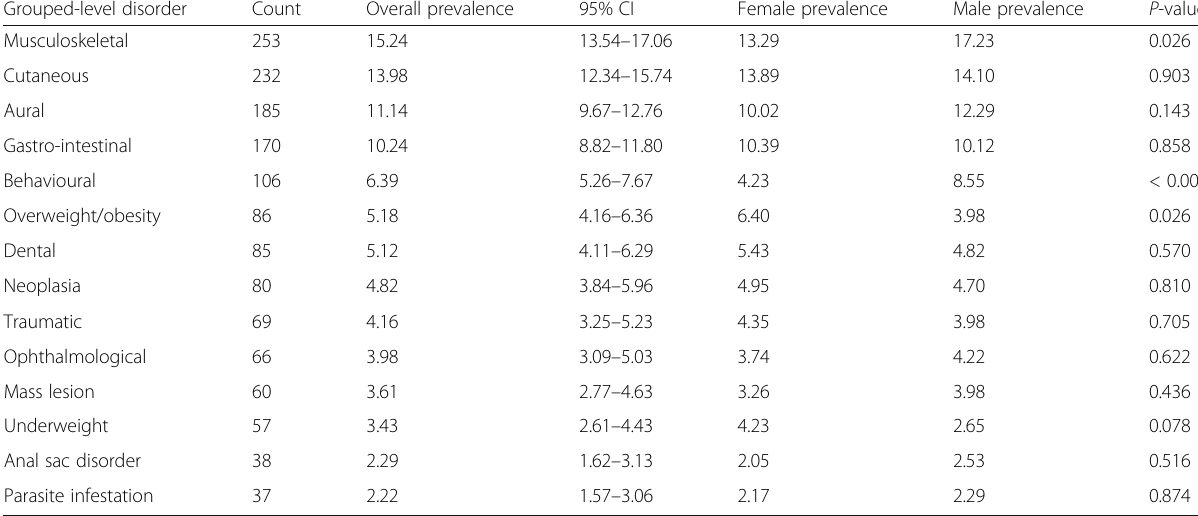
Table 4 Prevalence of the most common disorder groups recorded in German Shepherds Dogs ( n = 2197) attending UK primary-care veterinary practices participating in the VetCompass TM Programme from January 1st, 2013 to December 31st, 2013 Grouped-level